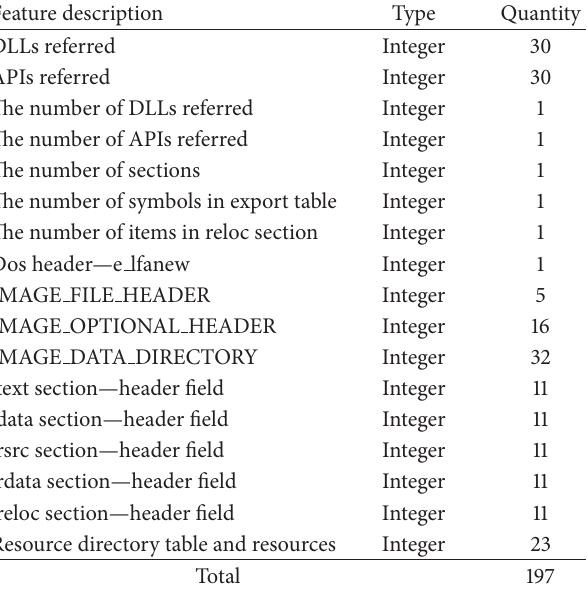
Table 2: List of the features extracted from PE